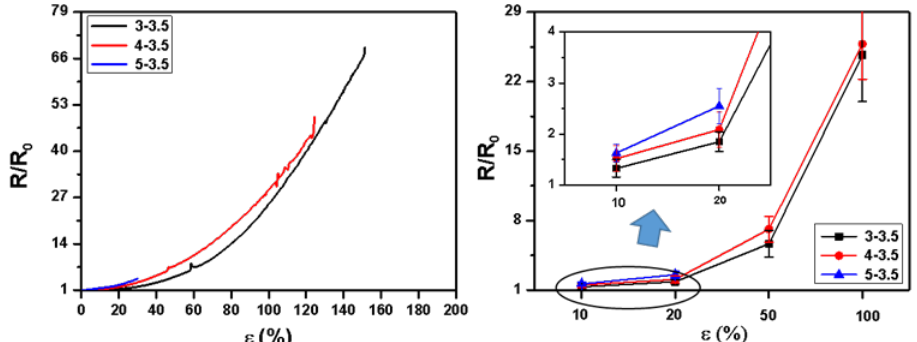
Figure 9. Relative electrical resistance of side-by-side fiber mats under different tensile strain.